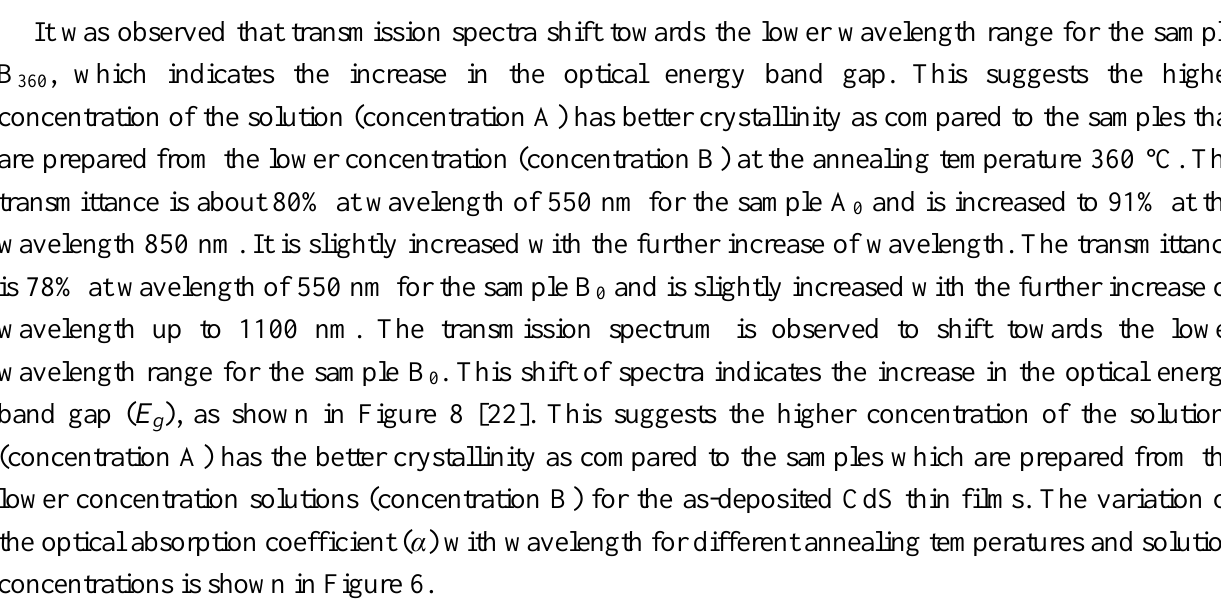
Figure 6. Absorption coefficient ( α ) for different annealing